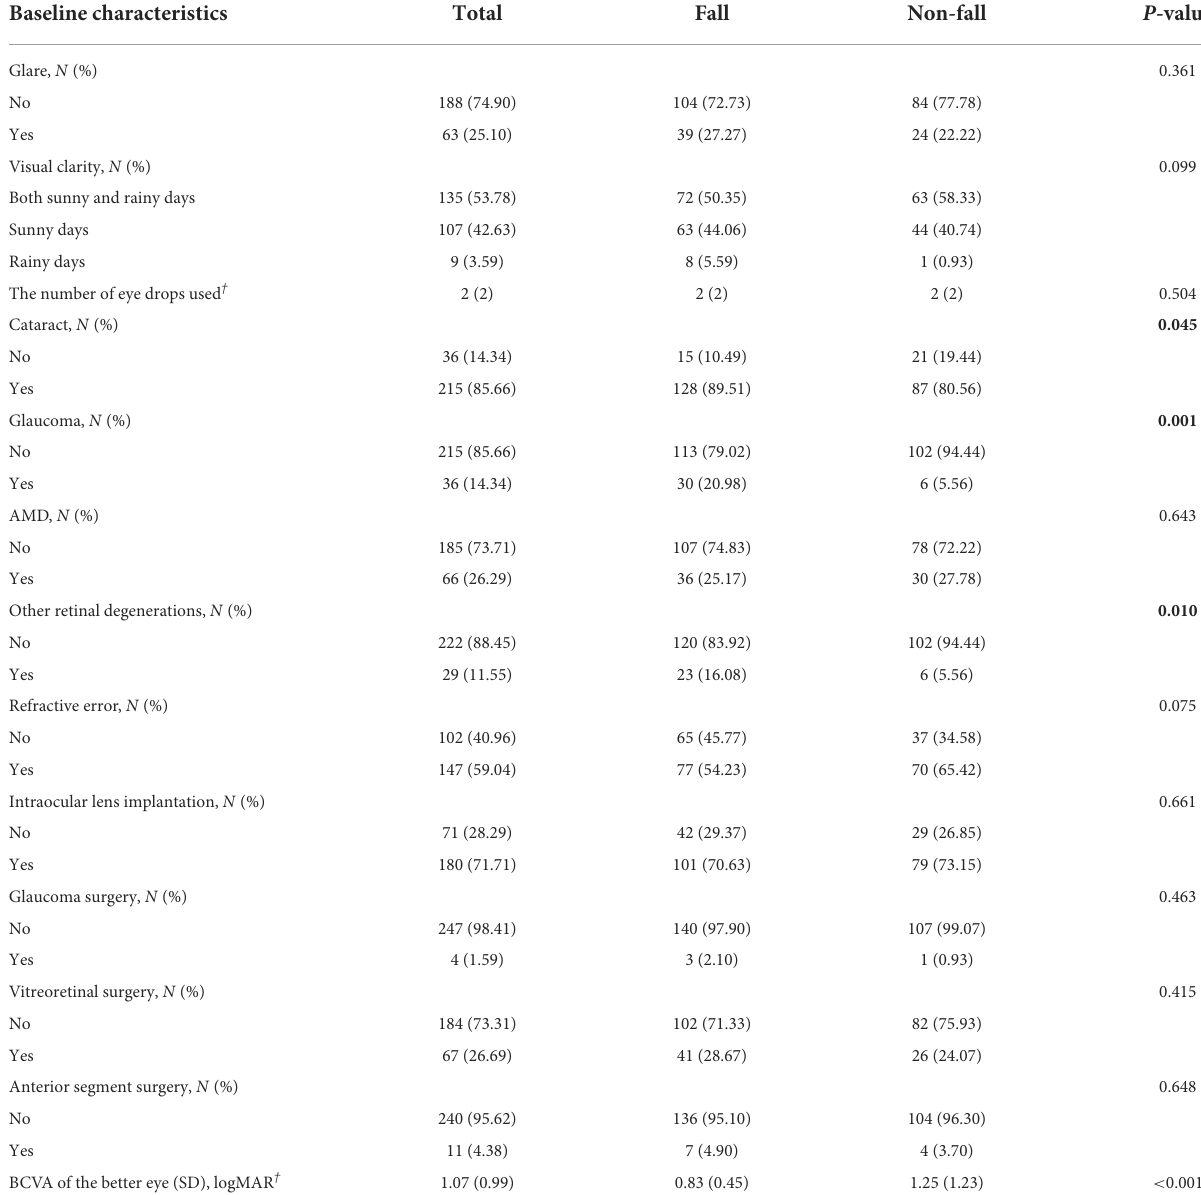
TABLE 2 Baseline ophthalmic conditions stratified by fall status at follow-up. Baseline